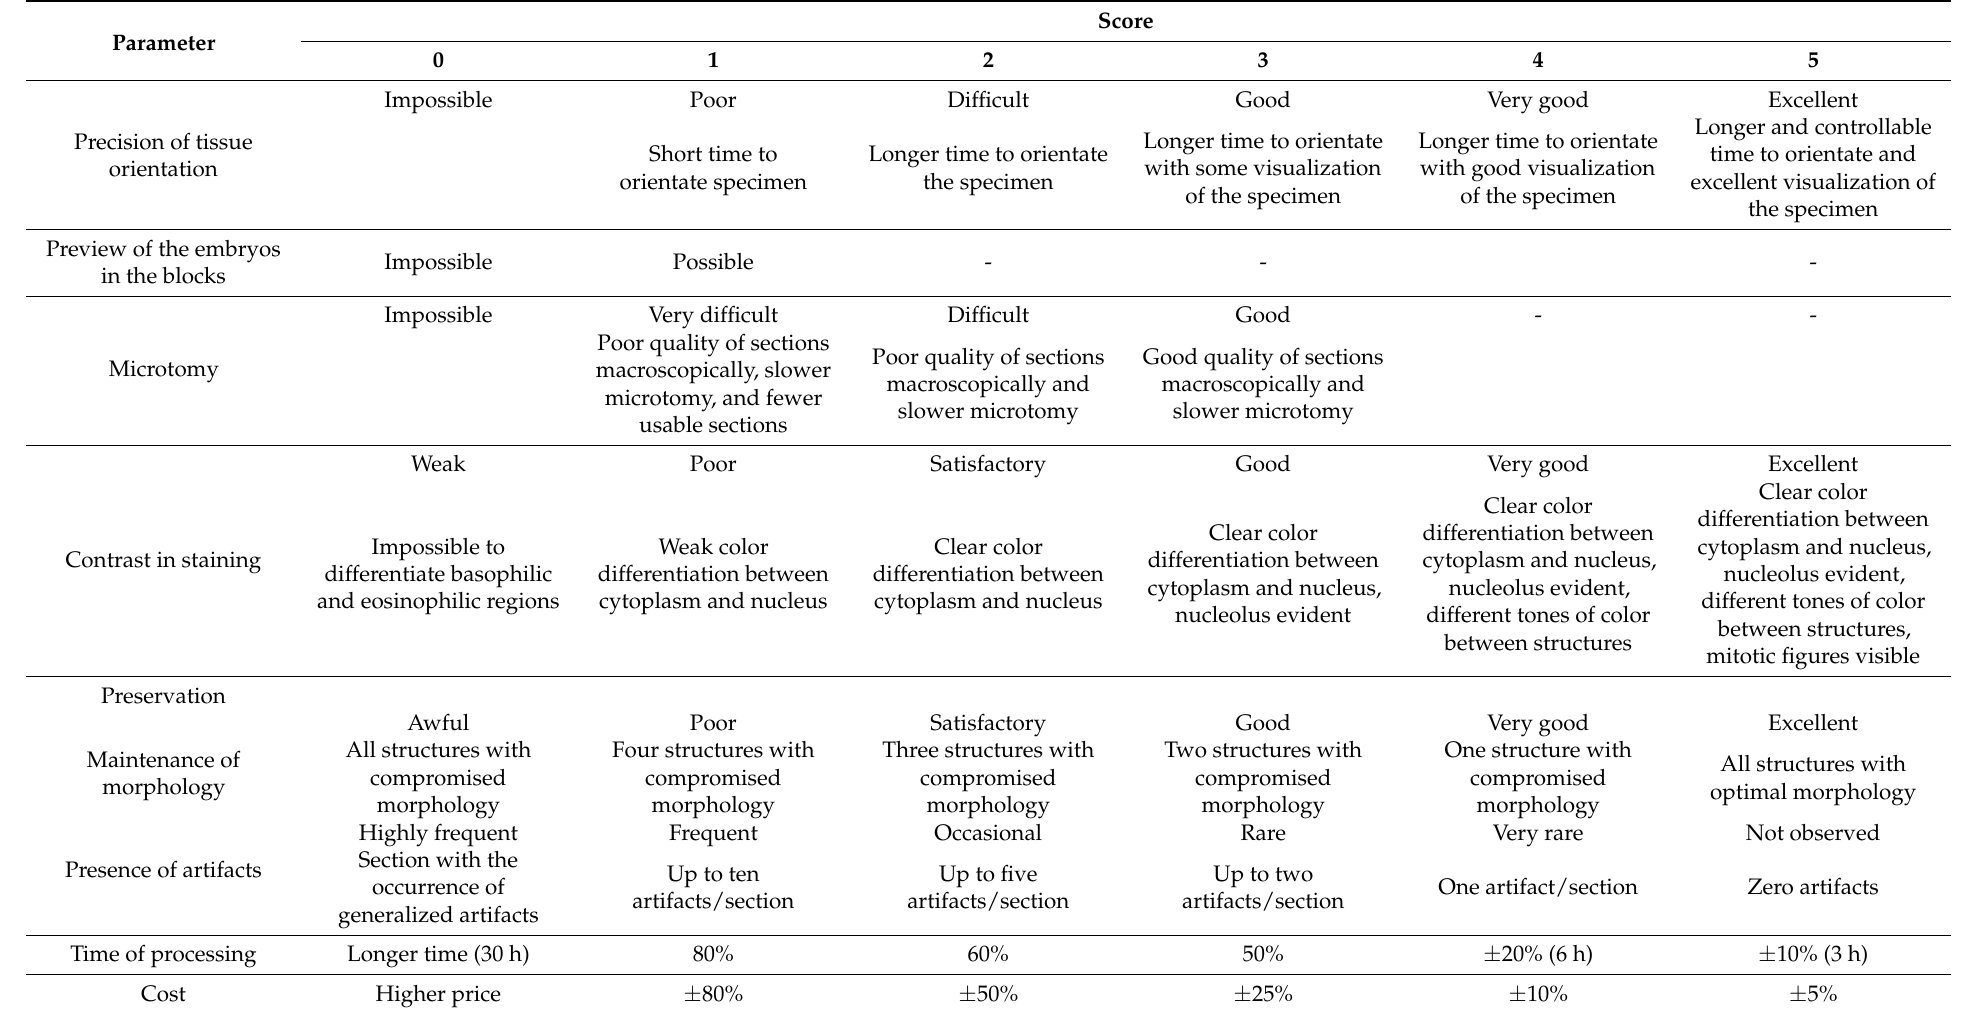
Table 8. Evaluated parameters with corresponding classification and